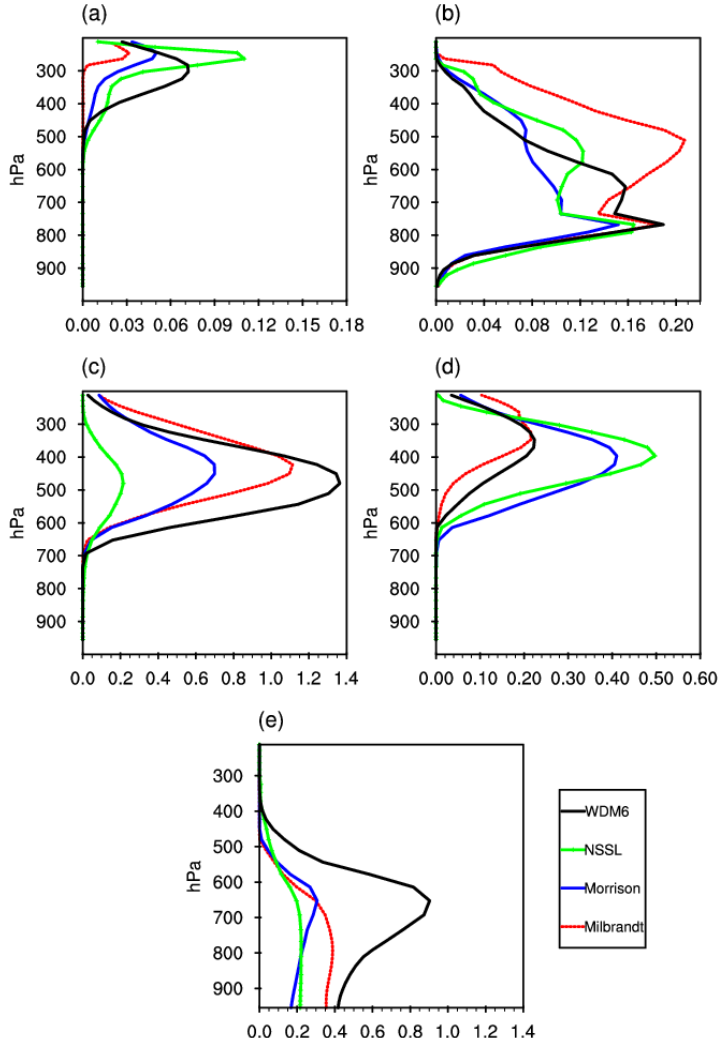
Figure 16. Vertical profiles of domain−averaged hydrometeors mixing ratio (units: g·kg −1 ) in strong convective areas with four different double-moment MP schemes at 2230 UTC 15 April 2016. ( a ) ice, ( b ) cloud water, ( c ) graupel, ( d ) snow, ( e ) rain water (black line: WDM6 scheme, green line: NSSL scheme, blue line: Morrison scheme, red line: Milbrandt scheme).